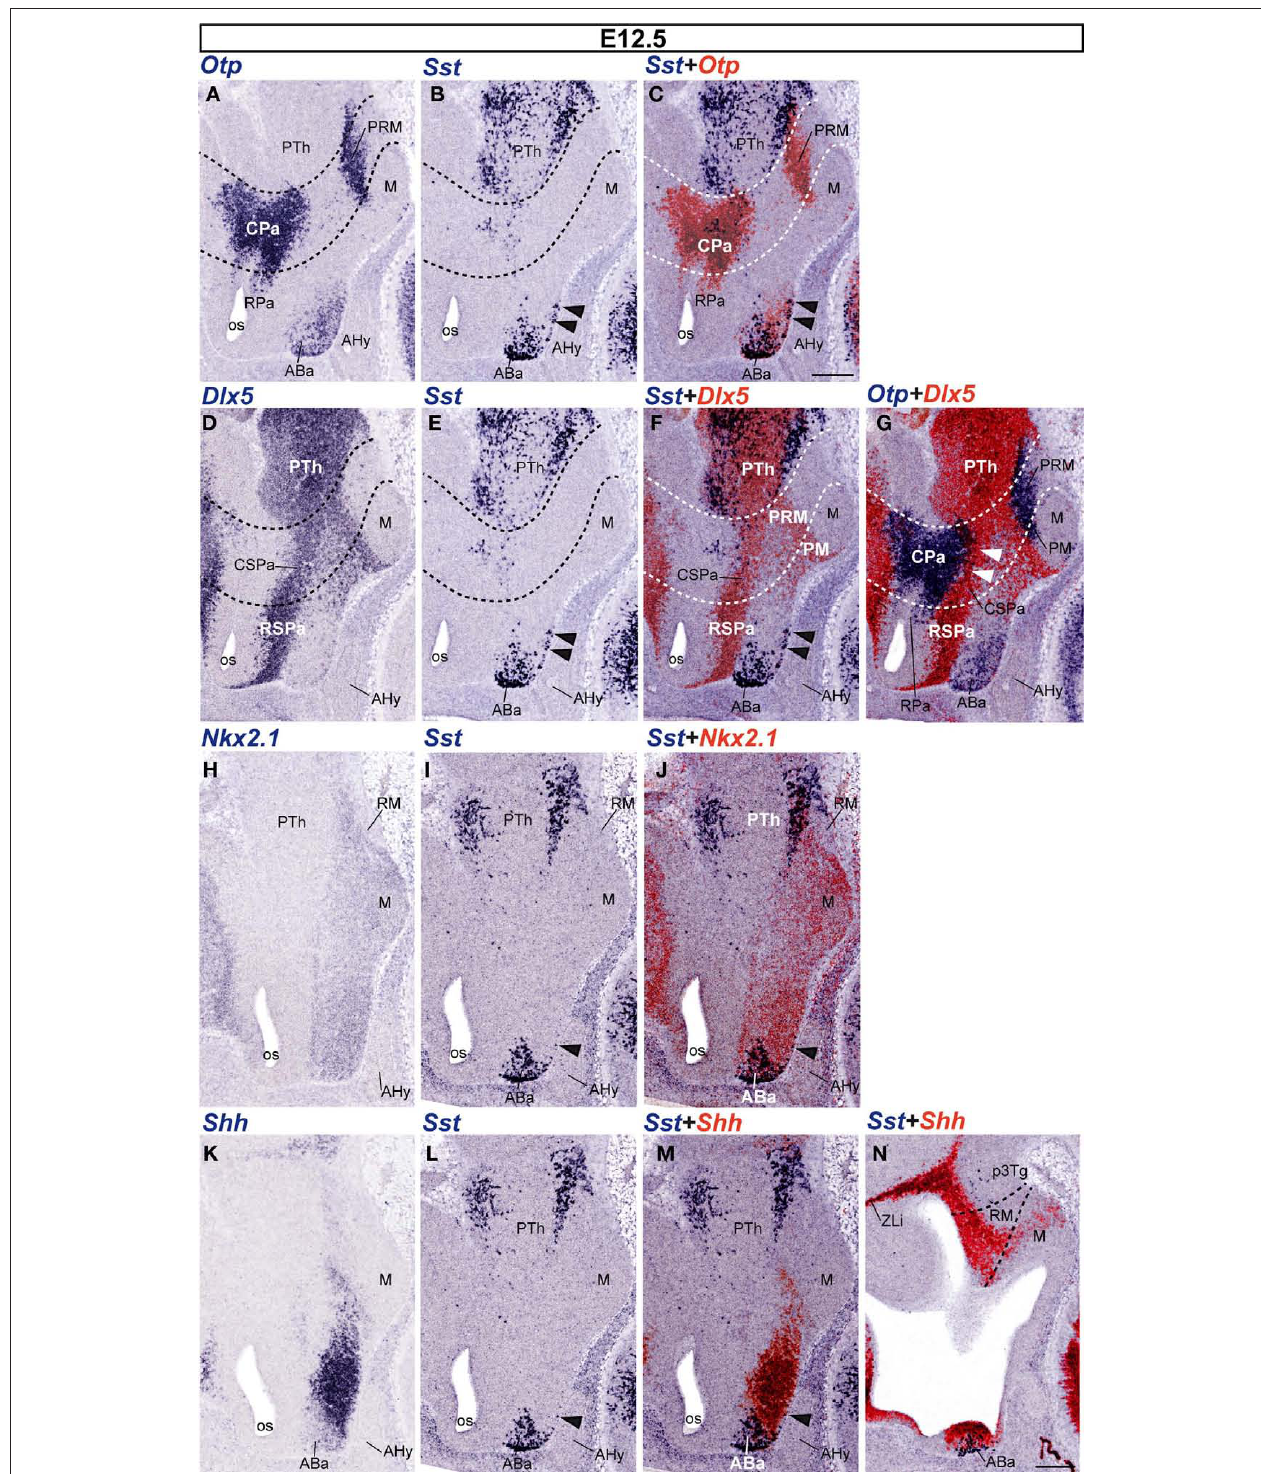
distinguished from the hypothalamic elements, found rostral to the hypothalamo-diencephalic boundary (caudal dashed line). The black arrowheads mark the incipient ventralward subpial displacement of some ABa-derived Sst cells. The white arrowheads in (G) indicate the sparse Otp -positive cells present within the CSPa subdomain. Bars = 200